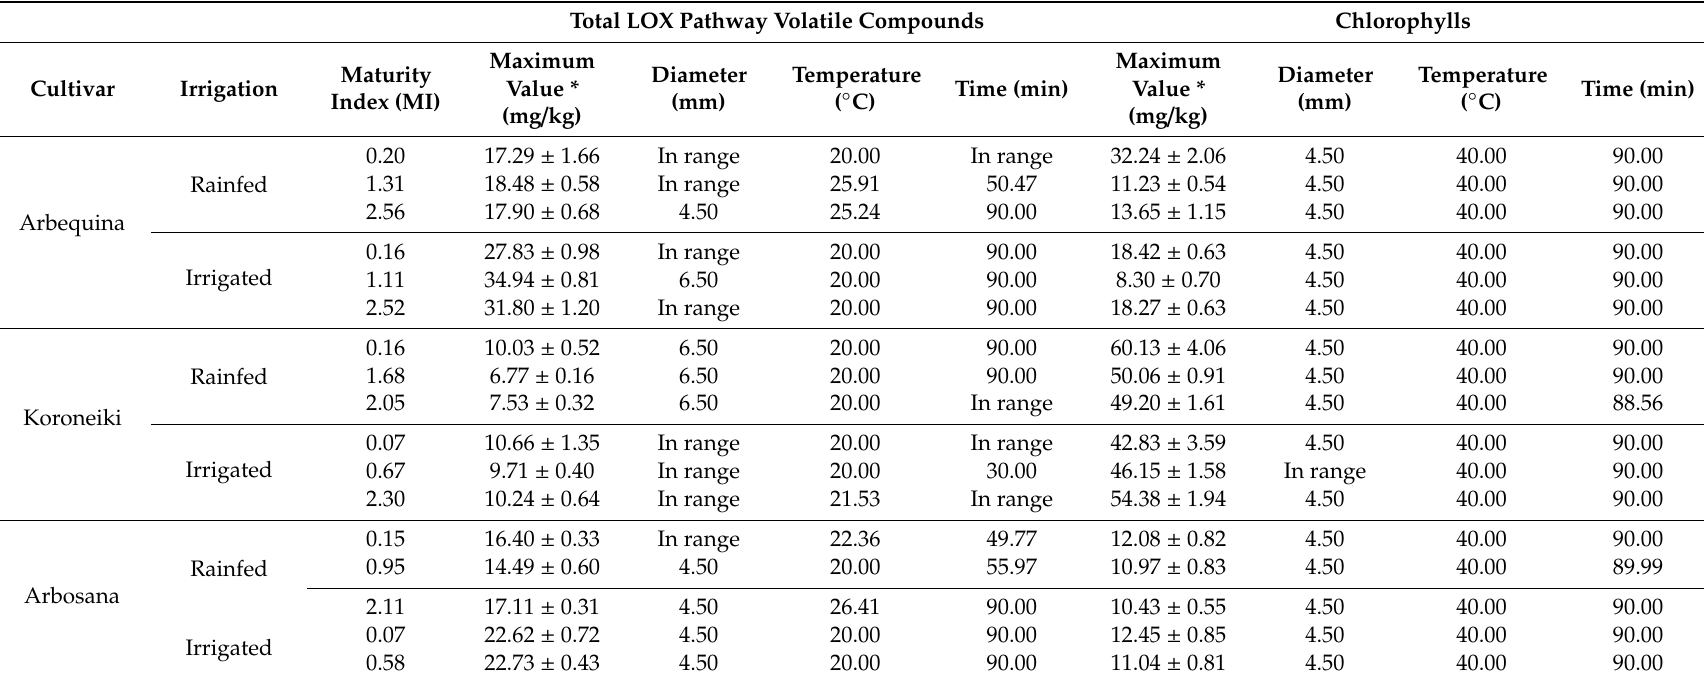
Table 5. Optimal values for volatile compound and chlorophylls